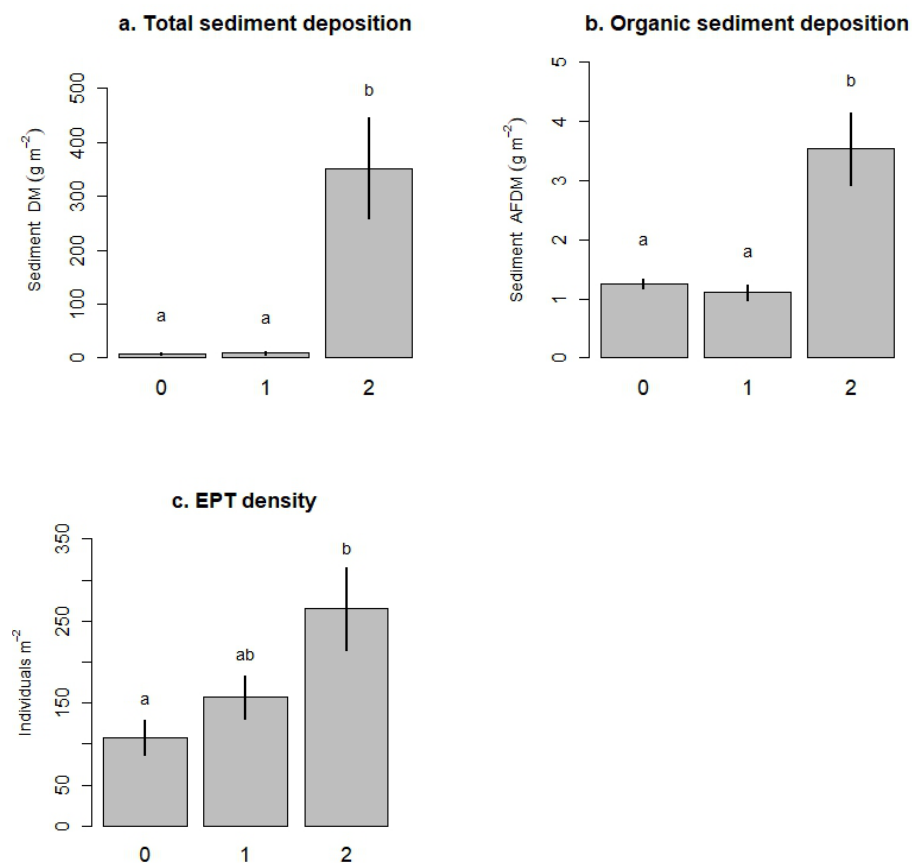
Figure 8. Bar plots illustrating the effect of tributary level of disturbance on total sediment depo- sition ( a ), organic sediment deposition ( b ), and EPT density ( c ) in recipient second-order channels. Treatments in the x-axis represent: no disturbance in the tributaries (0, tributary treatment C + C in Figure 1), one tributary disturbed (1, tributary treatment C + NS in Figure 1), two tributaries disturbed (2, tributary treatment NS + NS in Figure 1). Bars represent the mean of each tributary treatment ( ± SE, n = 4). Letters indicate significant differences among the treatments according to Tukey’s Honestly Significant Difference tests. Table 3. Summary of independent t-test s to compare response variables in second-order channels fed by tributaries where the nutrients and sediment were applied in combination (cumulative; tributary treatment b in Figure 1) and second-order channels fed by tributaries where the stressors were applied separately (single; tributary treatment c in Figure 1). Significant effects ( P < 0.05) are indicated in bold. Cumulative Single t